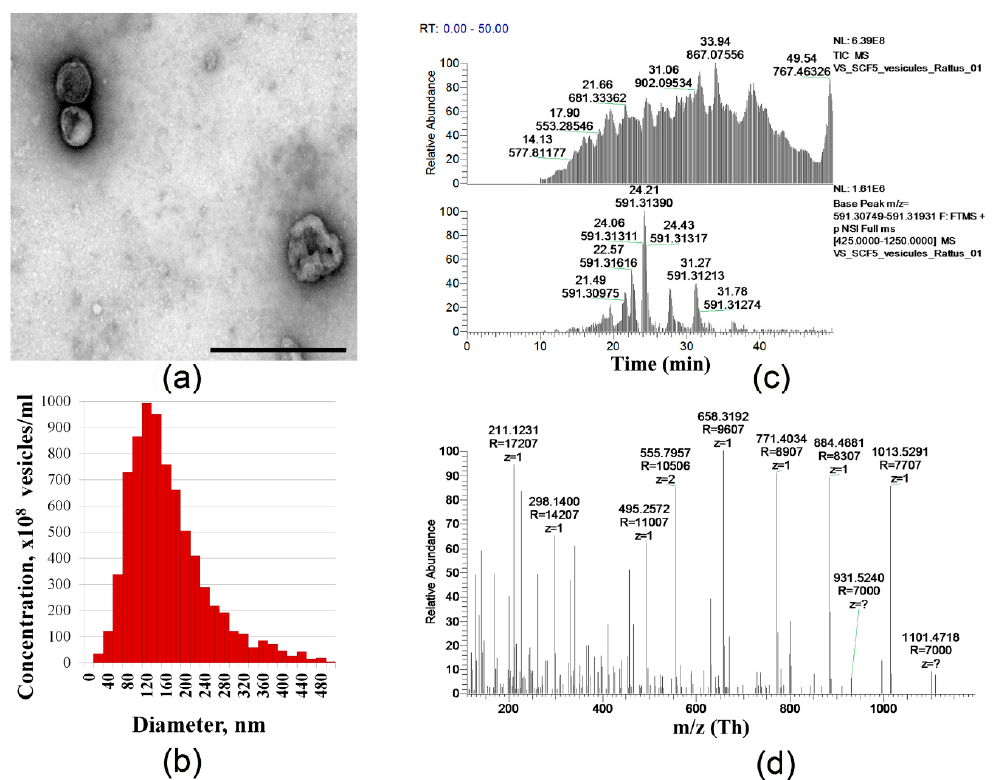
Figure 2. Paracrine and expression activity of SCF-MSC. ( a ) Representative transmission electron micrograph of EVs fractions, scale bar—500 nm; ( b ) A typical particle size distribution histogram of EVs from rat MSC obtained by Nanoparticle Tracking Analysis (NanoSight LM10); ( c ) Representative total ion current chromatogram (top) and extracted ion chromatogram (bottom) for SCF peptide (104–124 aa); ( d ) ESI-MS/MS spectrum of the SCF peptide (104–124 aa).